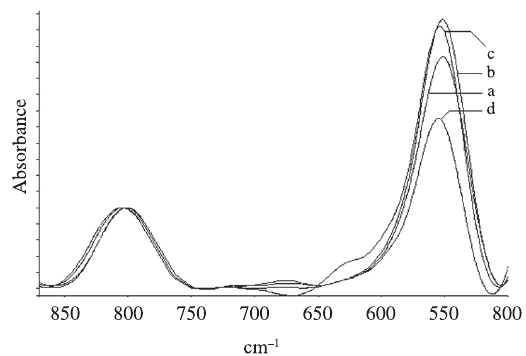
Figure 12. Superposition of FTIR spectra between 870 and 500 cm –1 in KBr pellets of zeolite samples a) NHT, b) HT560, c) HT760 and d)